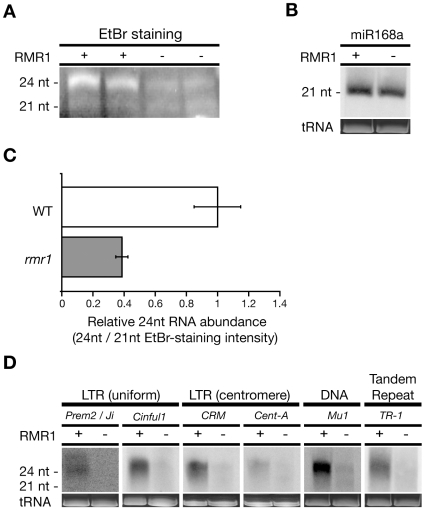
24 nt RNA populations are reduced in rmr1 mutants.(A) EtBr staining of PAGE fractionated small RNAs from rmr1-1 homozygotes (−) and rmr1-1/+ siblings (+). (B) Small RNA northern blot hybridized with radiolabeled oligonucleotide complementary to miR168a. (C) Ratio of EtBr-staining intensity of the 24 nt RNA populations from rmr1-1/+ (WT) and rmr1-1/rmr1-1 (rmr1) genotypes standardized to the 21 nt RNA species (+/− 1 s.e.m.; adjusted so WT = 1). (D) Small RNA northern blots hybridized with radiolabeled riboprobes homologous to multiple repetitive elements found in the maize genome.